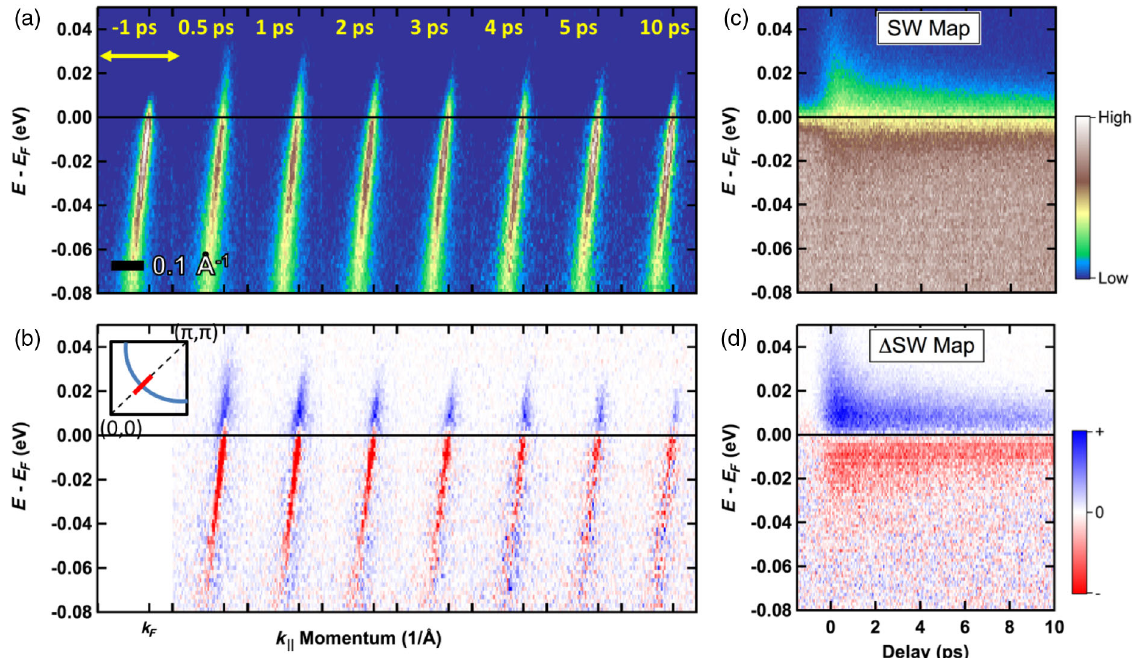
FIG. 1. Nodal response to ultrafast 4 - μ m pump from an optimally doped, T C ¼ 91 K Bi-2212 sample. Data are taken at the nodal position, shown in the inset to panel (b), at an equilibrium temperature of T ¼ 25 K, and a 4 - μ m pump fluence of 60 μ J = cm 2 . Panel (a) shows raw ARPES spectra at various time delays. Panel (b) shows the transient spectra, defined by subtracting the equilibrium spectrum from each delay. Panel (c) shows a map of SW vs delay obtained by integrating the ARPES spectrum along the momentum cut, shown by the yellow arrow in panel (a). Panel (d) is the analogous map for the transient data, referred to as a Δ SW map, produced similarly to panel